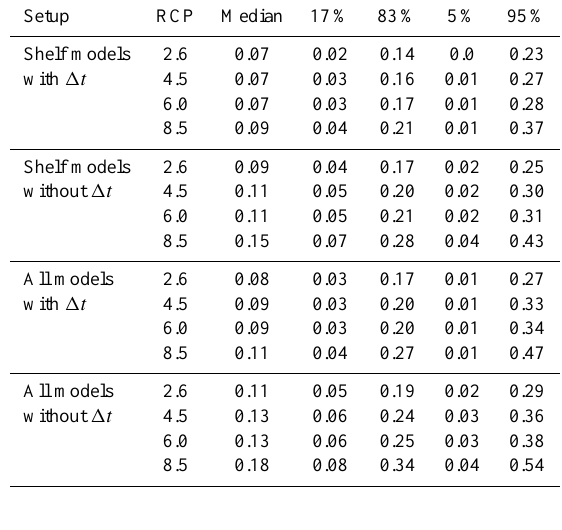
Table 5. East Antarctic Sea sector: scaling coefficients and time delay 1t between increases in global mean temperature and sub- surface ocean temperature anomalies. Model